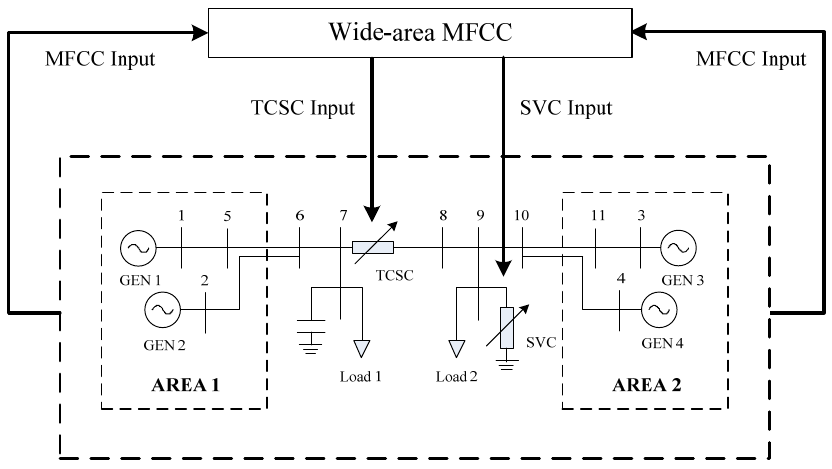
Figure 8. A four-machine, two area test system equipped with TCSC and Figure 8. A four ‐ machine, two area test system equipped with TCSC and SVC.